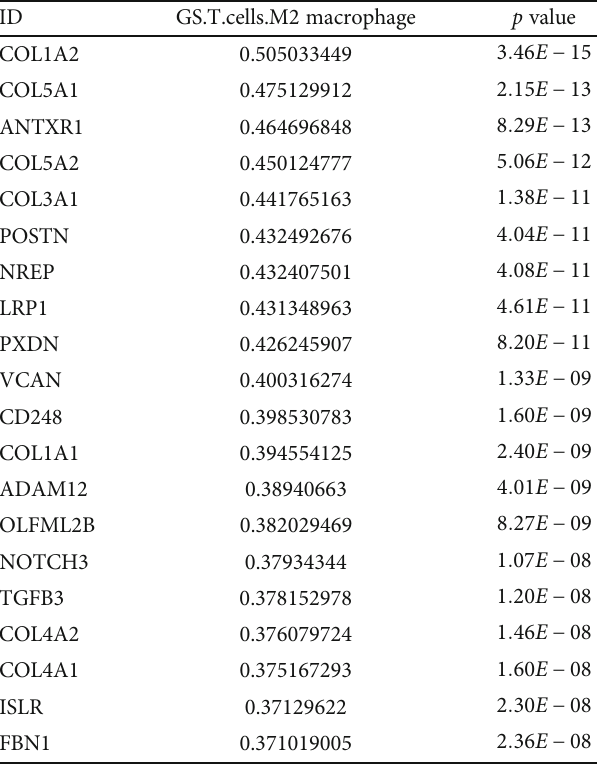
Table 2: The top 20 gene signi fi cance for M2 macrophage cell- related genes in the yellow